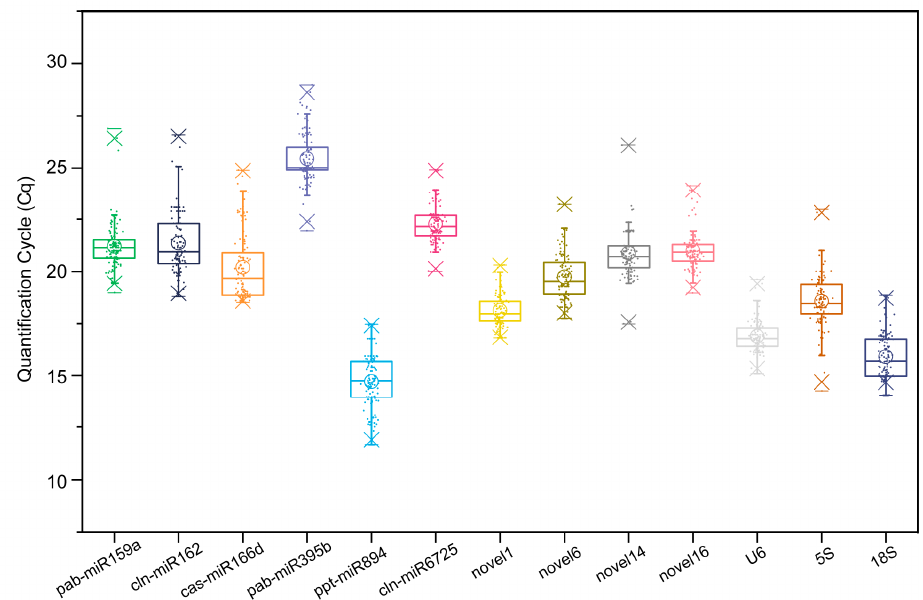
Figure 2. Quantification cycle values of 13 candidate reference genes in different tissues and under multiple stresses. The box indicates the 25th and 75th percentiles, with the line across the box representing the median. Whiskers and asterisks represent 99% confidence intervals and outliers, respectively. Upper and lower horizontal lines indicate the maximum and minimum values, respectively, and small circles represent the average values.